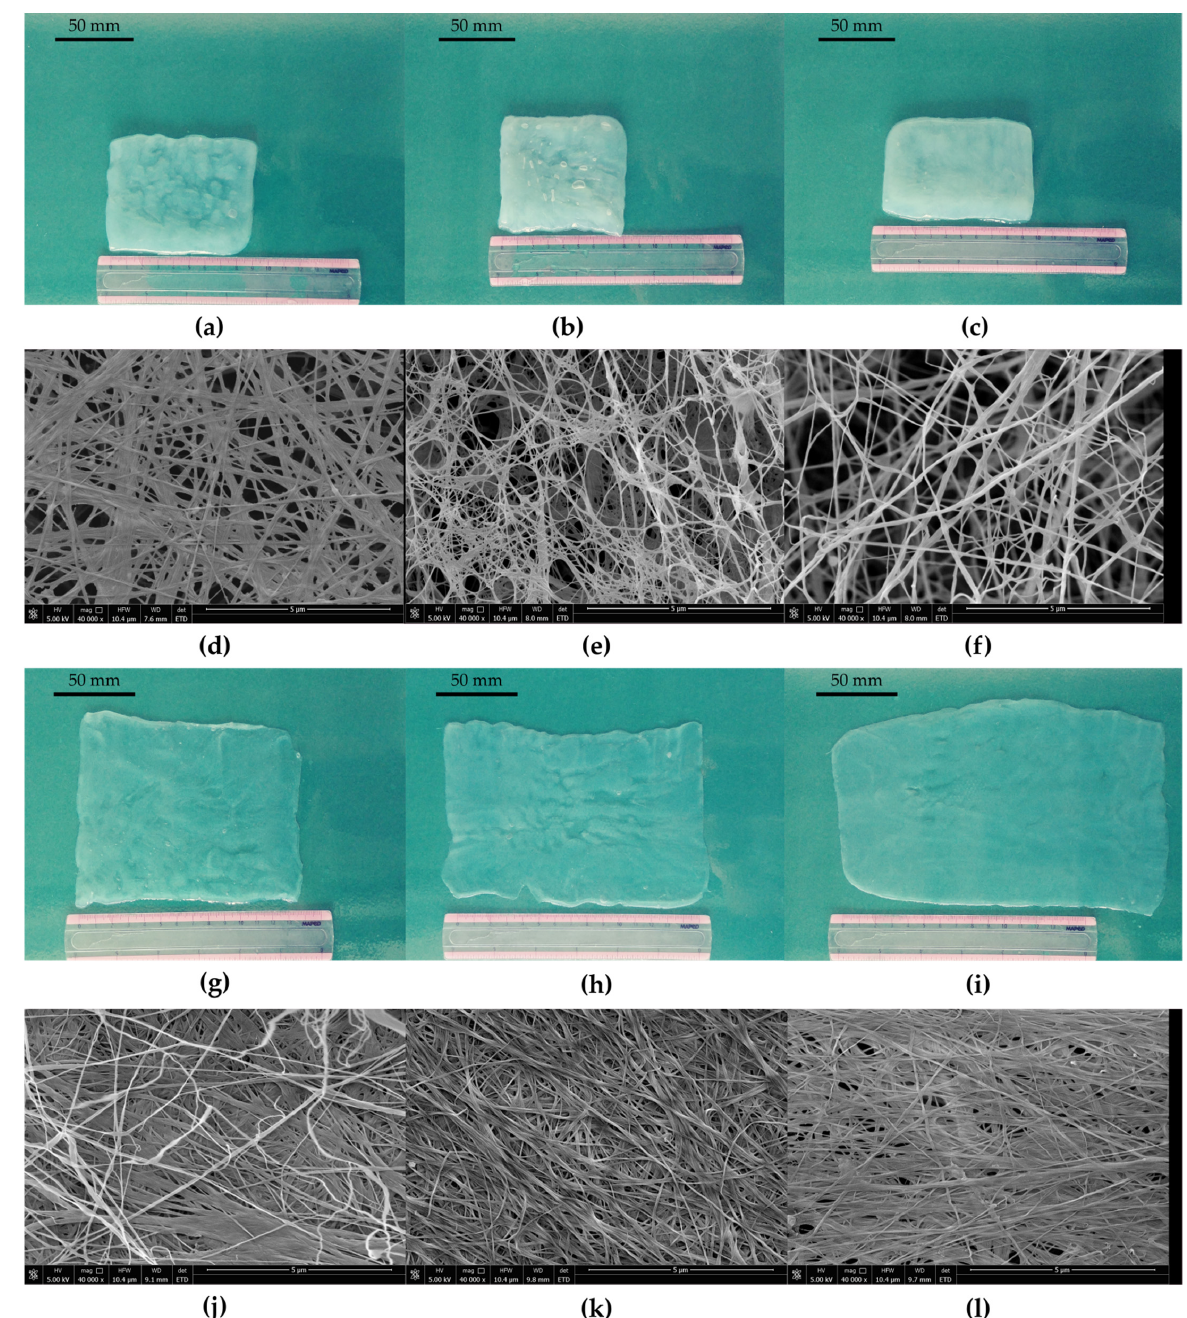
Figure 9. Photographs and SEM images of BNC synthesised by K. hansenii SI1 in SH medium ( a , d ) before and ( g , j ) after stretching; photographs and SEM images of BNC synthesised by K. hansenii SI1 in SH medium supplemented with 0.5% vitamin C ( b , e ) before and ( h , k ) after stretching; photographs and SEM images of BNC synthesised by K. hansenii SI1 in SH medium supplemented with 1.0% vitamin C ( c , f ) before and ( i , l ) after stretching; the SEM images were recorded at a magnification of 40,000× (bar—5 µm).